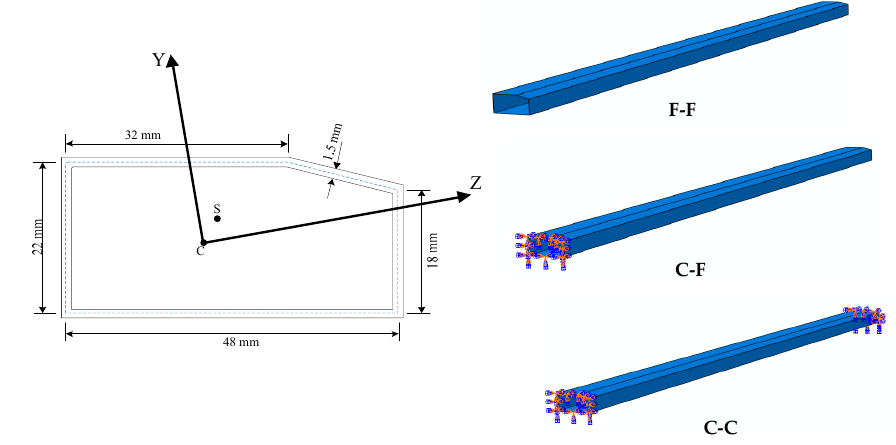
16 of 27 Figure 7. The plot of relative error on natural frequencies versus modal index for example 2 under different boundary conditions: ( a ) C-C; ( b ) C-F; ( c ) F-F. 5. Experimental Model 5.1. Case Study As the S-FEM analysis is an approximate calculation method, comparing the results obtained by TMM with S-FEM analysis may lead to an undefined problem, as the S-FEM analysis is an approximate calculation method. As pointed out in Section 1, experimental evidence about thin-walled beams with arbitrary cross-sections are rather scarce in the literature. Therefore, taking into account the controversial point discussed in this paper